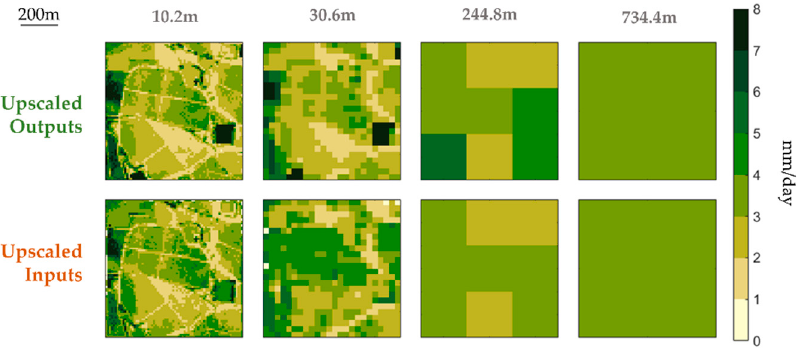
Figure 12. Spatial distribution of ET across the different scales (columns) and both scaling approaches (UO for the upper row and UI for the lower). Data about the example date of 11th June.